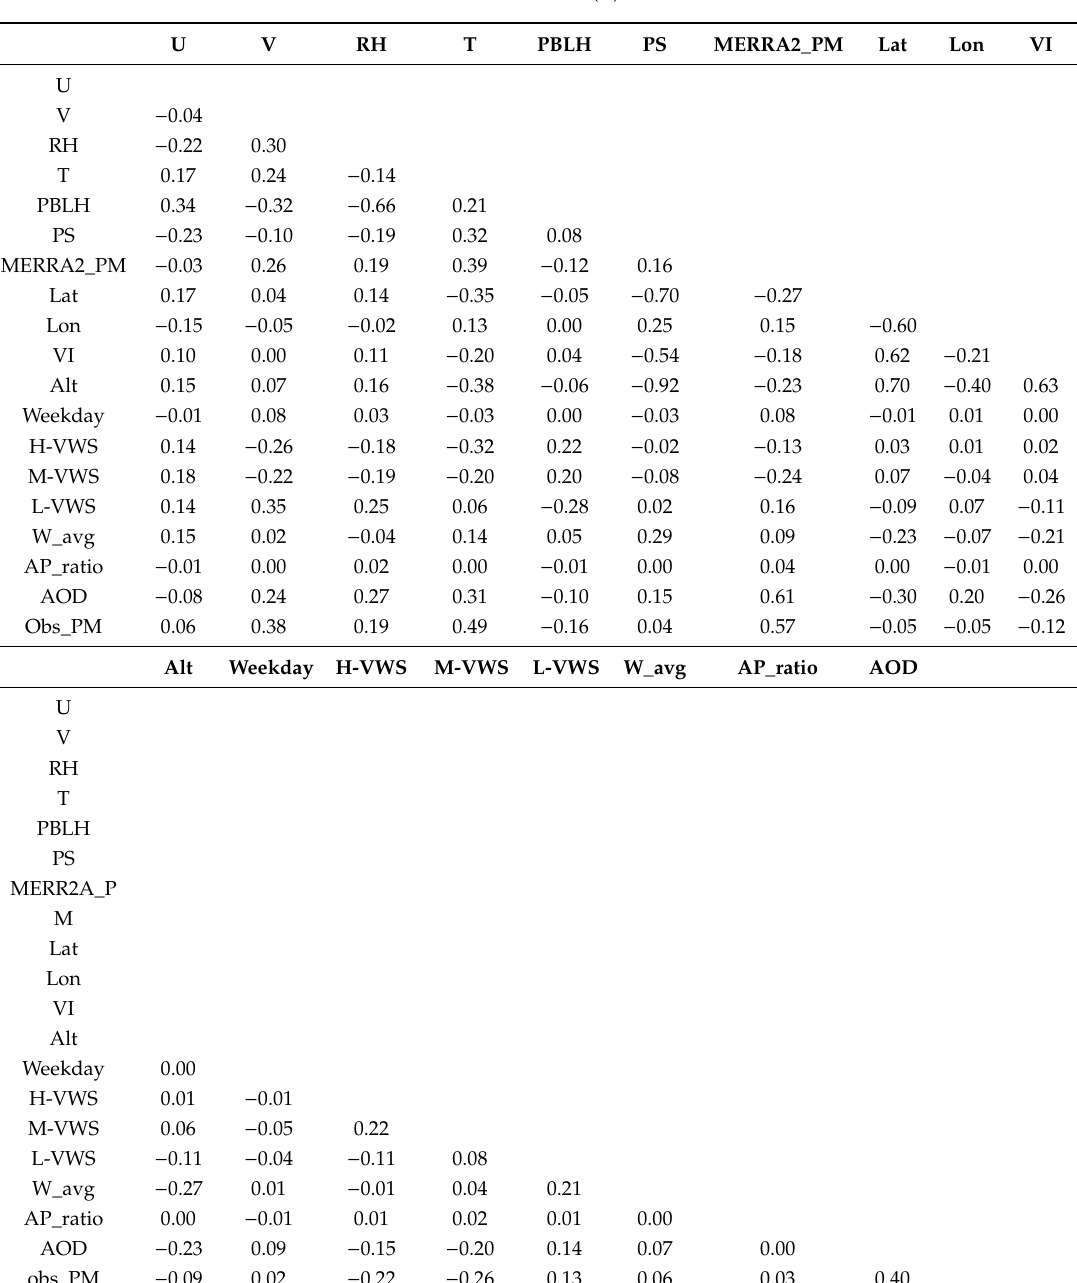
Table A1. Correlation coe ffi cients (R) between